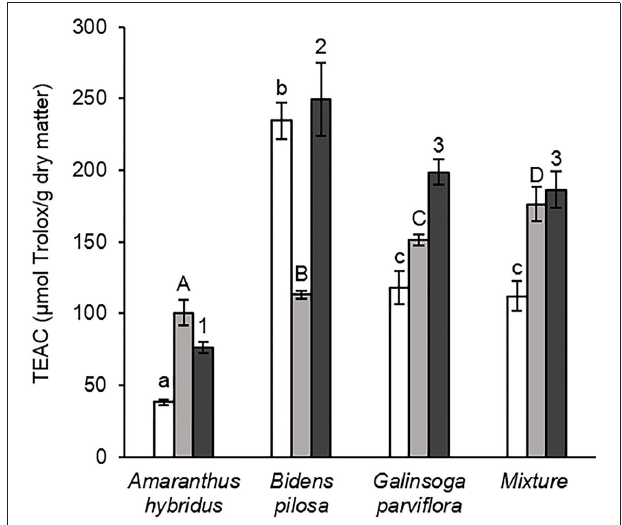
FIGURE 6 | Antioxidant activity in lombi by different methods: DPPH ( (cid:3) ), ABTS ( (cid:4) ), and FRAP ( (cid:4) ). The results are expressed by µ mol Trolox Equivalent Antioxidant Capacity (TEAC). Error bars represent ± standard deviation ( n = 9). Statistically significant differences between samples are indicated for DPPH (lowercase letters), ABTS (capital letters), and FRAP (ordinal